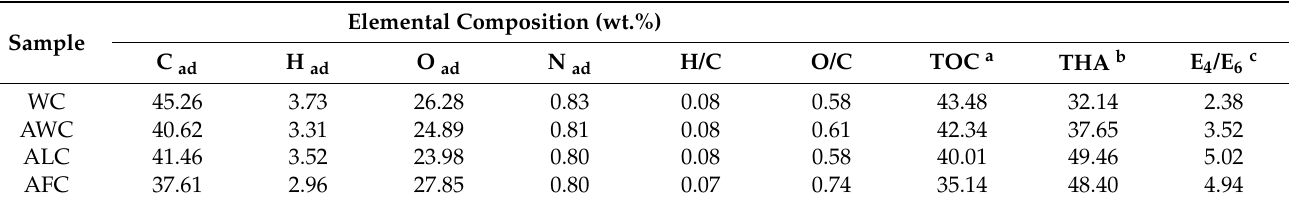
Table 1. Elemental Composition (%), Atomic Ratio Total Humic Acid (%), Water Humic Acid, and E 4 /E 6 Ratio of WC, AWC, ALC and AFC.